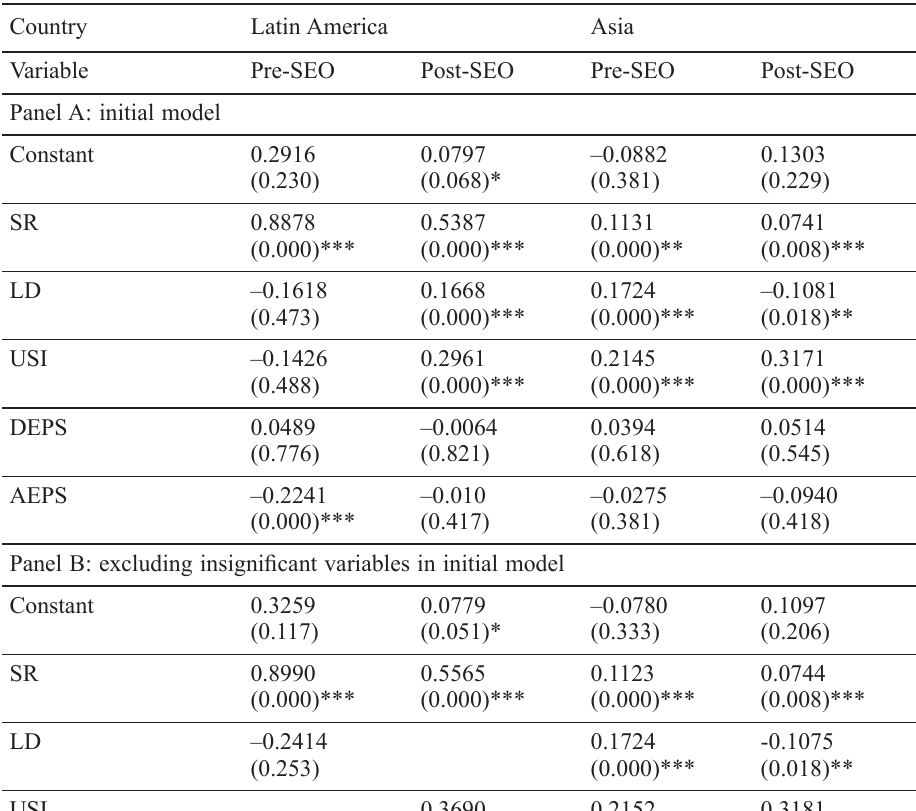
Table 12. Robustness checking: Panel system GMM